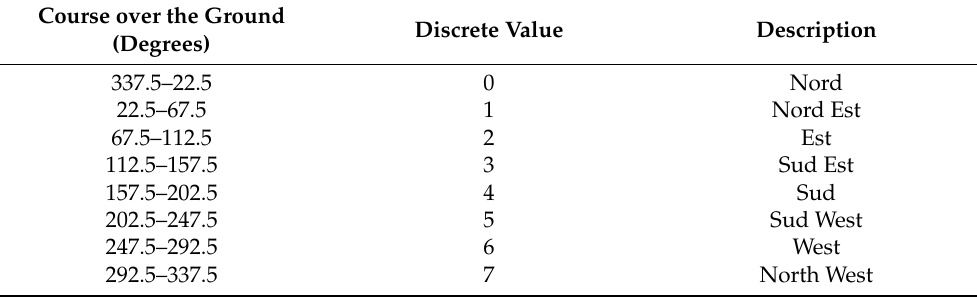
Table 1. Course discretization into 8 clock